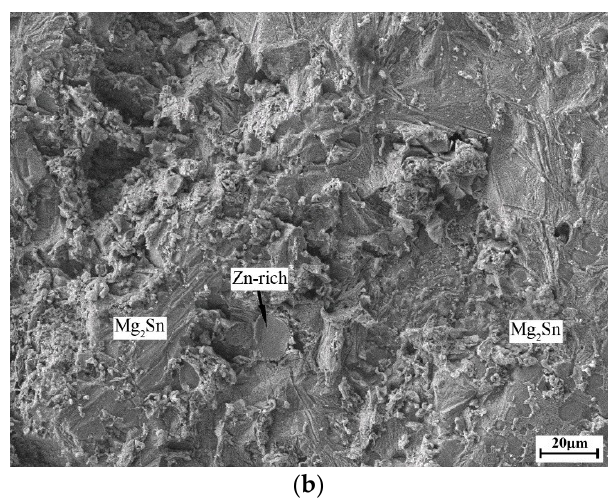
Figure 6. Fractography of the AZ31 magnesium alloy/6061 aluminum alloy joint bonded with the Sn-20Zn-0.1RE solder. ( a ) 6061 aluminum alloy side; ( b ) AZ31 magnesium alloy side.